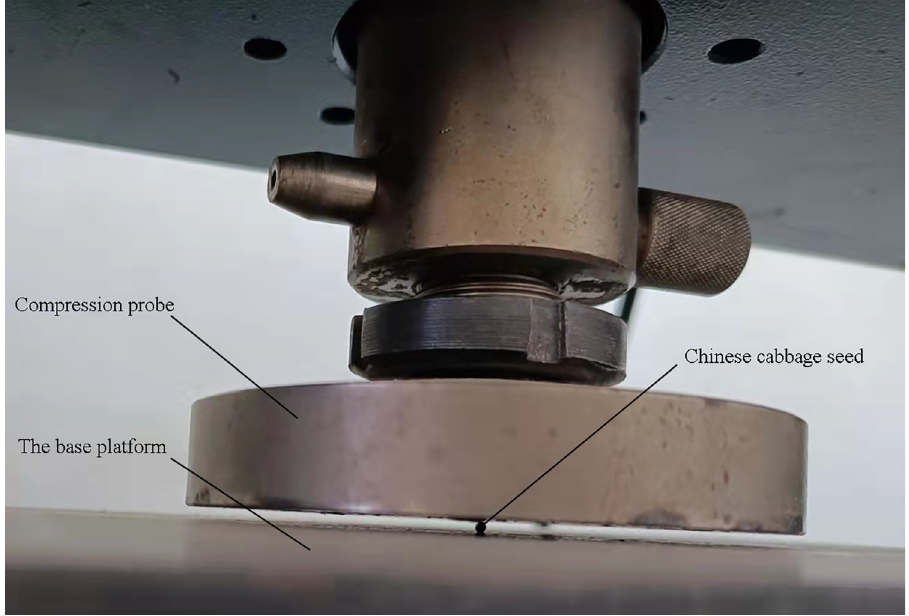
Fig 2. Compression test of Chinese cabbage